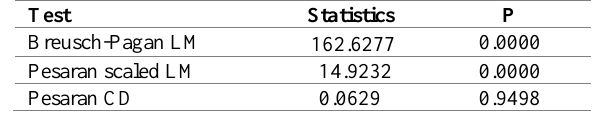
Table 8. Cross-sectional dependence test results of Model 2